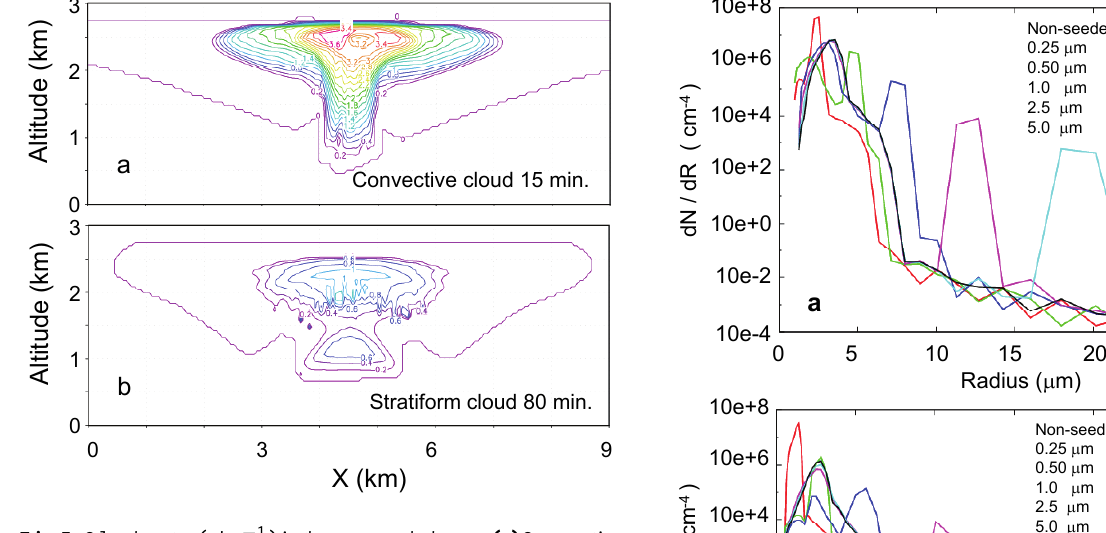
Fig. 5. Cloud water (gkg − 1 ) in the non-seeded case. (a) Convective cloud at 15min (10min after cloud initiation). (b) Stratiform cloud at 80min (30min after cloud initiation).